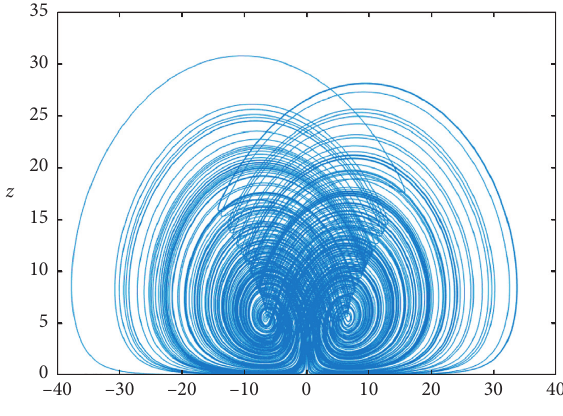
Figure 3: Dynamics of Lu et al.’s fractional-order system in (13)–(15) with the order κ � 0 . 92, in context of x and z